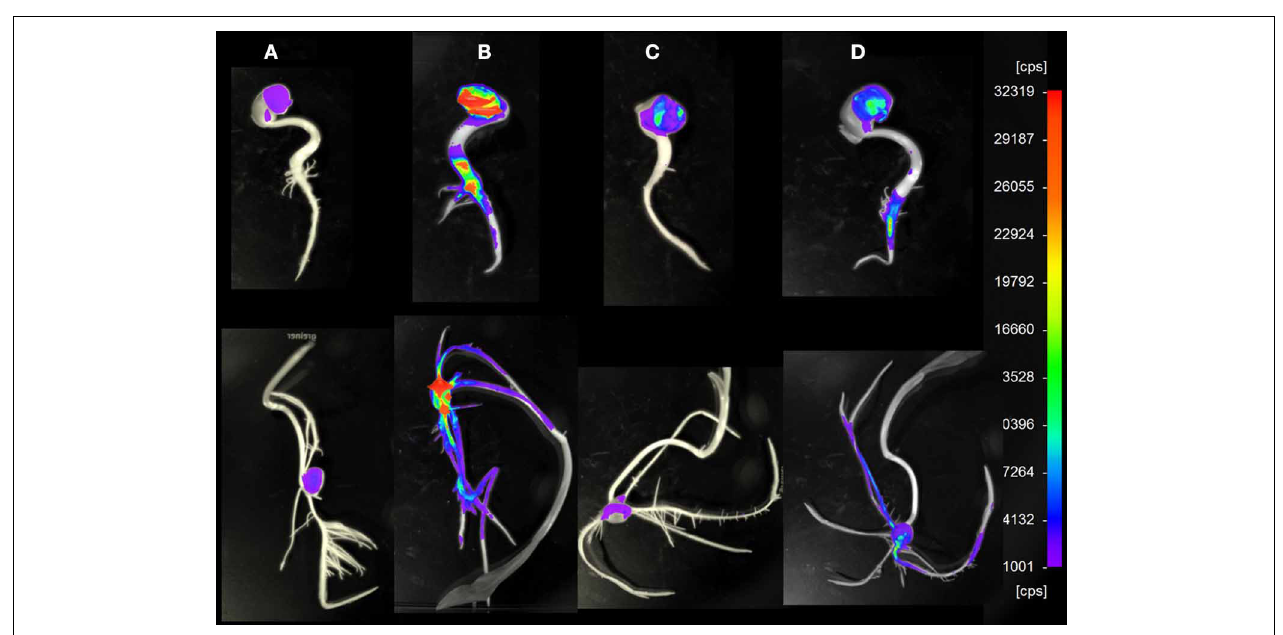
FIGURE 5 | Representative pictures of lupin (upper row) and maize (lower row) 7 day old seedlings colonized by B. phytofirmans PsJN wild-type or (cid:2) oxc mutant in single or combined inoculation. For imaging, a NightOWL LB 983 NC100 was used, under conditions where